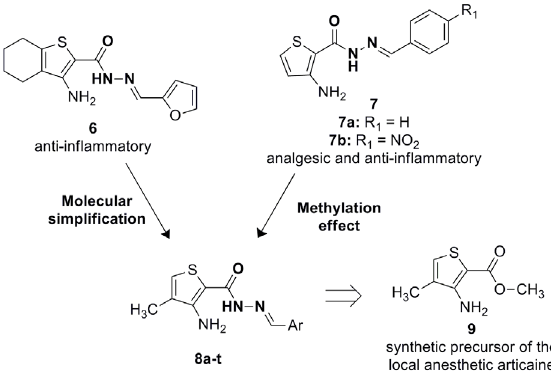
Figure 2 - Design concept of the N -acyl-hydrazone (NAH) derivatives ( 8a-t ).